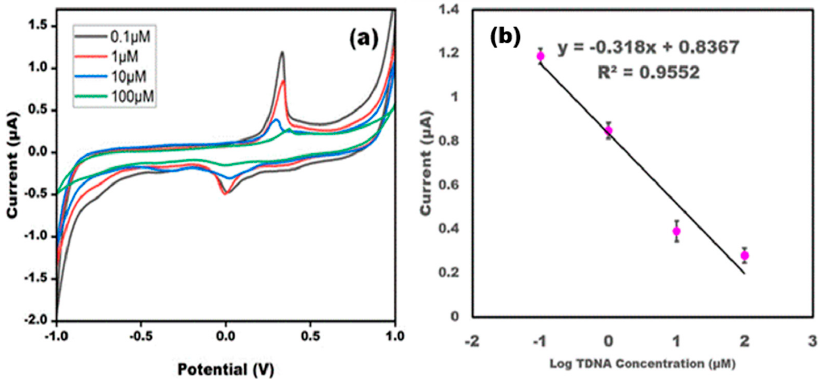
Figure 3. ( a )CV of DNA probe/AgNP/PBG-modified electrode using different concentrations of ZIKV-TDNA (0.1 µM, 1 µM, 10 µM, and 100 µM) in 10 mM methylene blue in 0.1 M KCl at 50 mV s − 1 in the potential range from − 1 V to +1V. ( b ) Linear curve of the current value and log of the target DNA concentration. The error bar represents the standard deviation of the sensor for each concen- tration repeated 5 times.